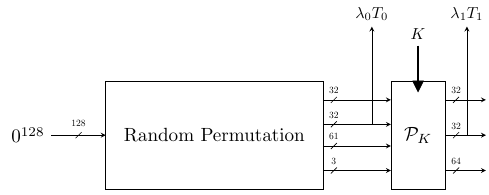
Figure 6: Linear trails of TinyJAMBU carrying the correlation of the